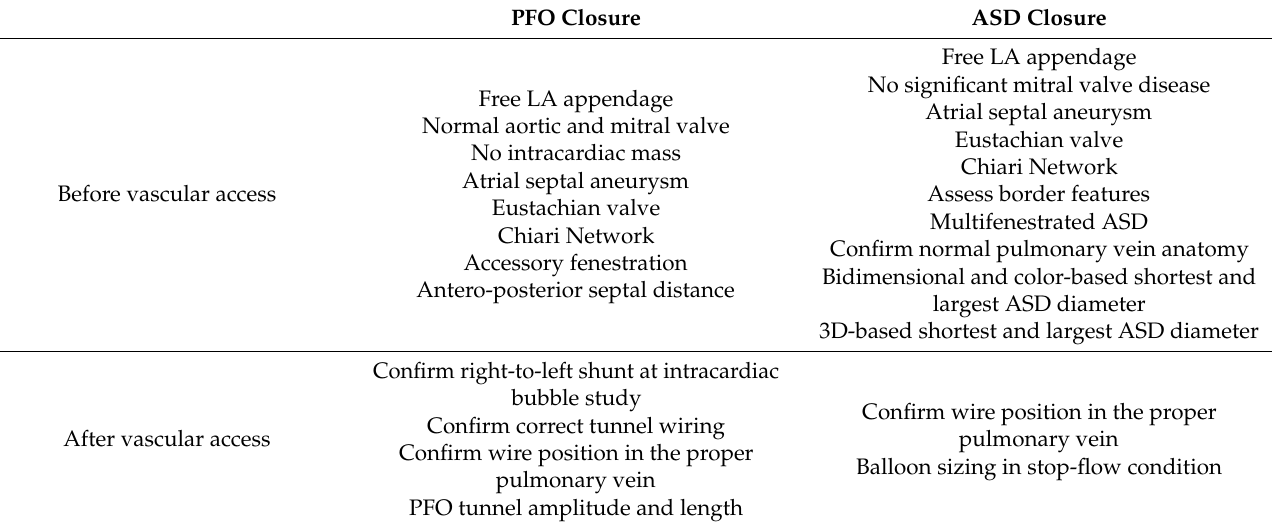
Table 3. Intra-procedural TEE checklist for PFO and ASD transcatheter